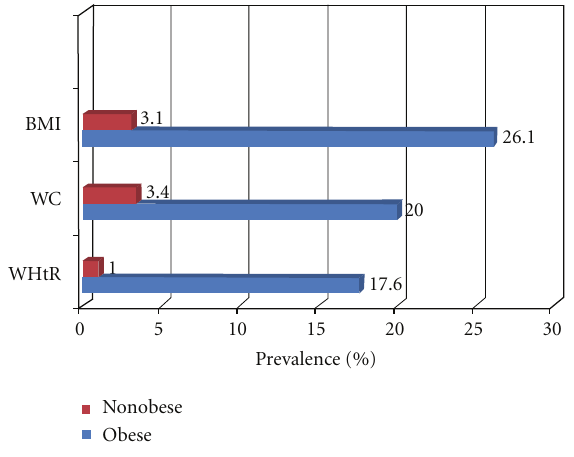
Figure 4: Prevalence of 3 or more metabolic syndrome abnormali- ties in obese and nonobese college